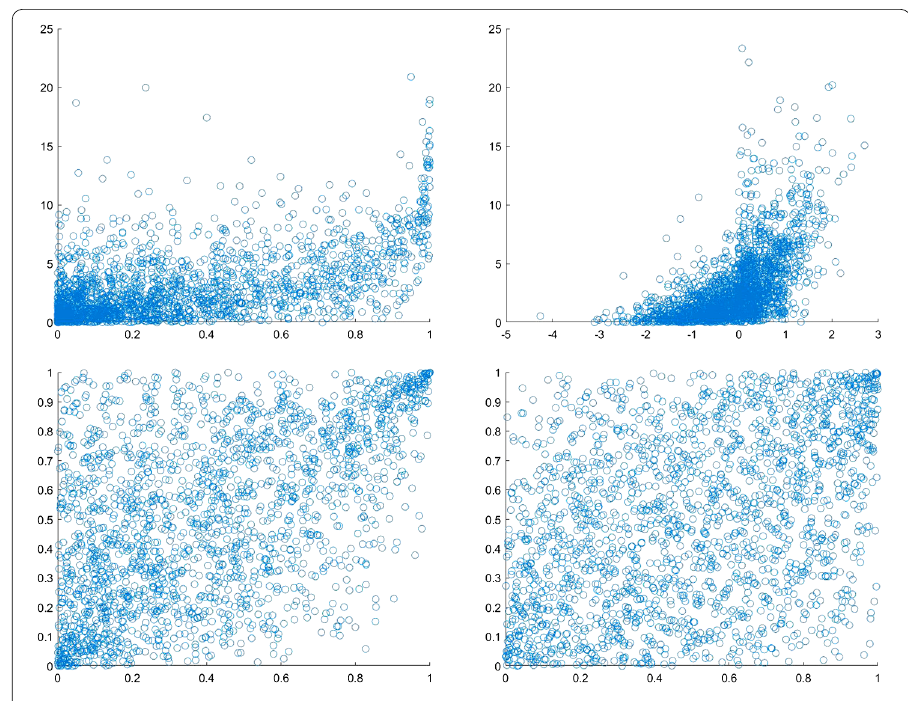
Figure 1 Scatter and rank-rank plots for a sample of size 2000 from the Gumbel copula based on censored data with τ = 1/2, once the margins have been transformed to F 1 and F 2 . ( a , top left): F 1 = B (0.5,0.7) and F 2 = ε (3); ( b , top right): F 1 = N (0,1) and F 2 = ε (3); ( c , bottom left): F 1 = F 2 = U (0,1); ( d , bottom right): the rank-rank plot for Gumbel copula